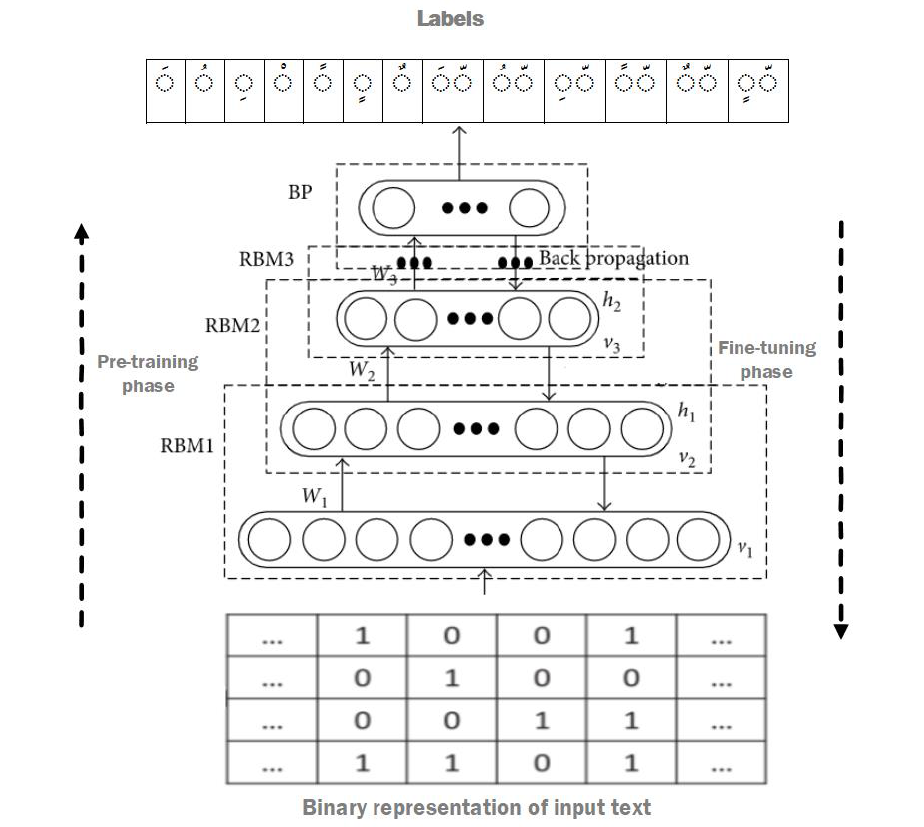
Figure 5. A schematic representation of the designed DBN model for the automatic diacritization of Arabic